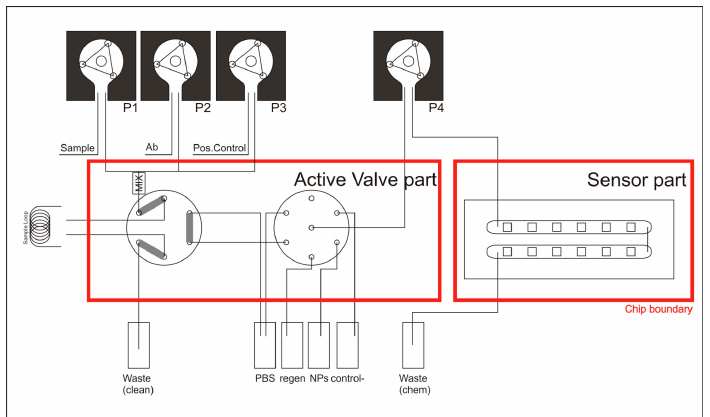
Figure 4. Schematic of the layout of the realized fluidic system. The three pumps upper left, are used to fill the sample loop with a mixture of solutions. The fourth pump is used to feed a selection of reagents through the sensing chip with the 12 BICELLs. The selection of the reagents is done through a selection valve (connected to containers), which also can connect to the sample loop to take up actual sample (There are in total seven reservoirs although in the scheme only six are represented).